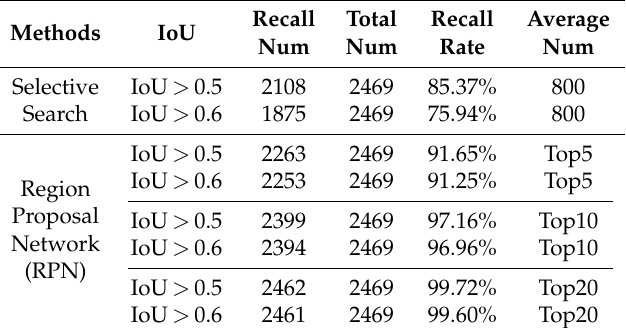
Table 1. The recall of Selective Search and RPN.